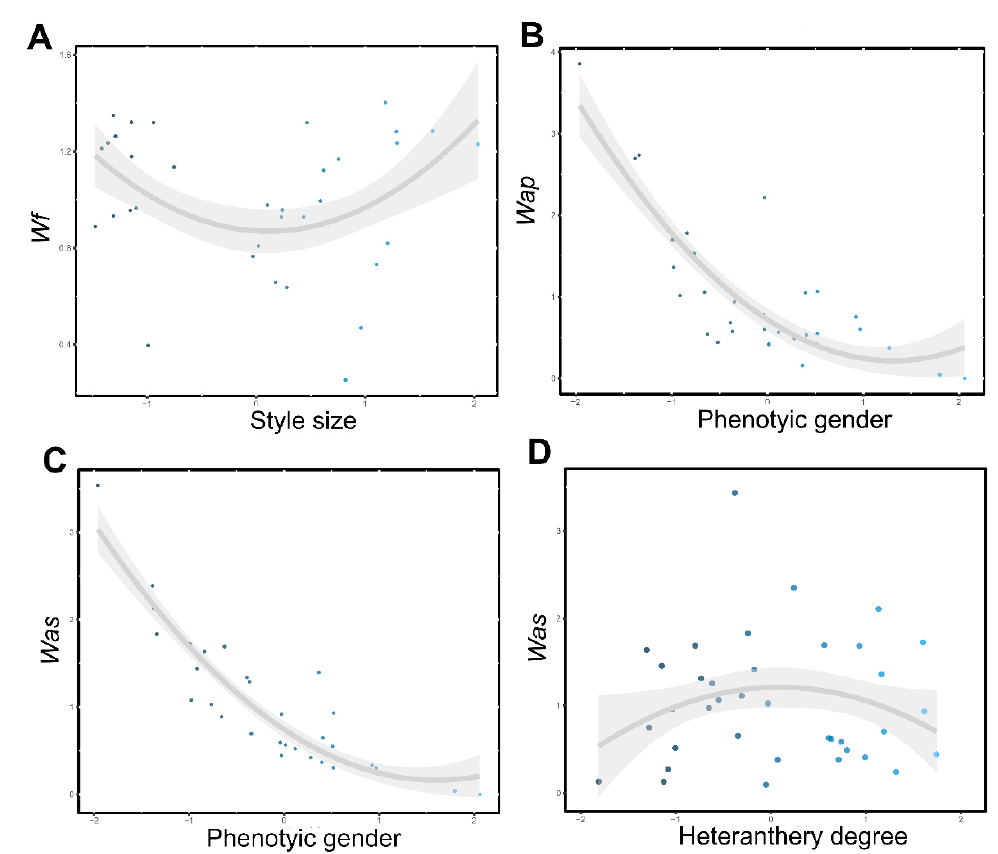
Figure 2. Representative surfaces of disruptive selection on style through seed number ( A ), on phenotypic gender through pollen removal of AP stamens ( B ) and AS stamens ( C ), and representative surface of stabilizing selection on heteranthery degree through pollen removal of AS stamens ( D ) in DEL population. Wf , Wap and Was correspond to the female and male (antepetalous stamens and antesepalous stamens, respectively) fitness components.